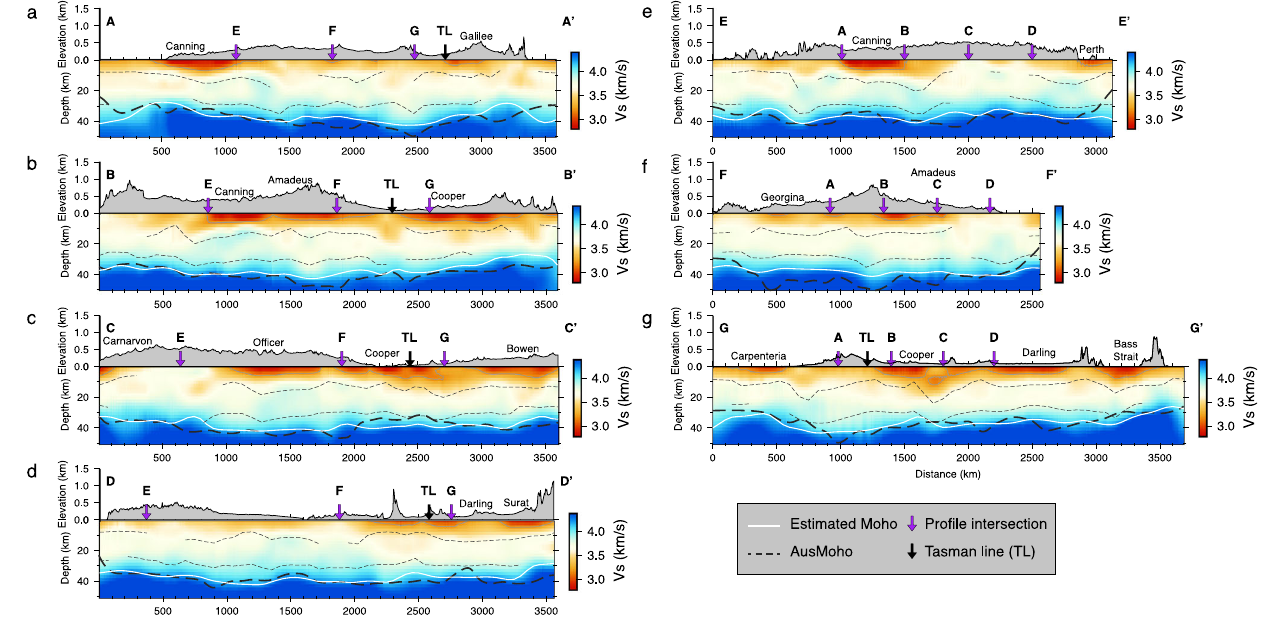
Fig.5|Cross-sectionsshowinglateralandverticalvariationofshearvelocities. a – d Four east-west oriented pro fi les. e A northeast-southwest oriented pro fi le sampling the western half of the continent. f A north-south oriented pro fi le sam- pling central Australia. g A northwest-southeast oriented pro fi le sampling the easternhalfofthecontinent.ThelocationsareshowninFig.4b.Thegraysolidlines